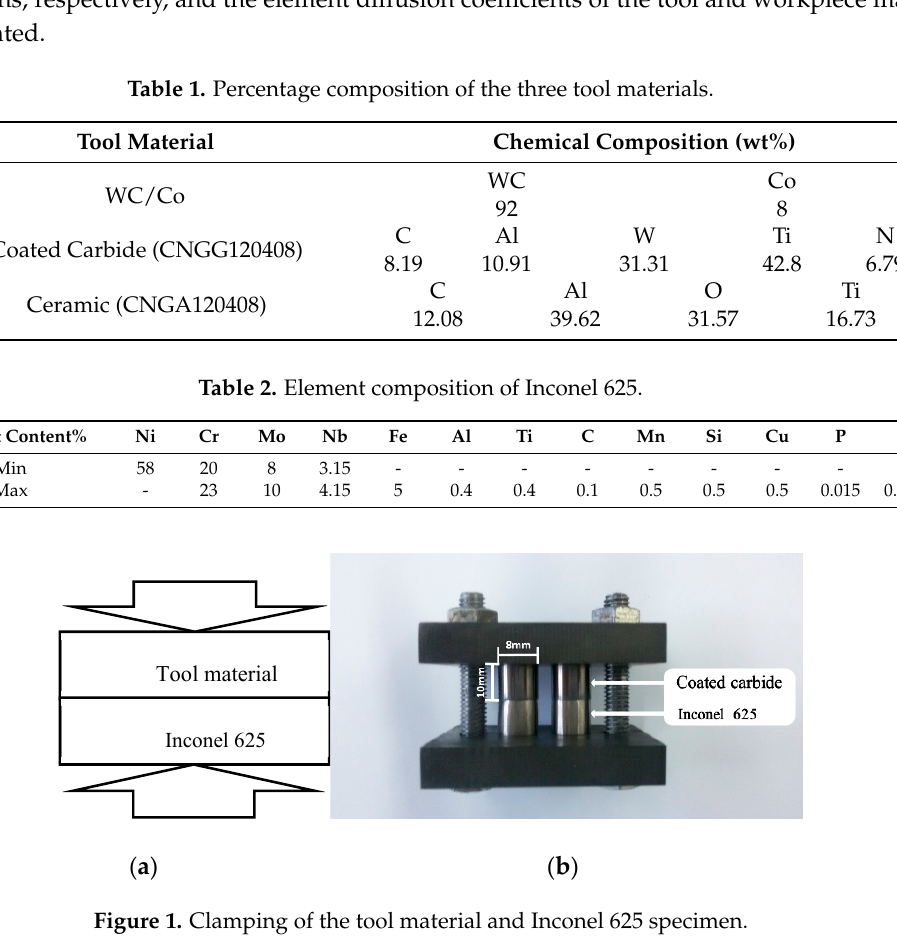
Table 3. Possible oxidation reactions on the tool.